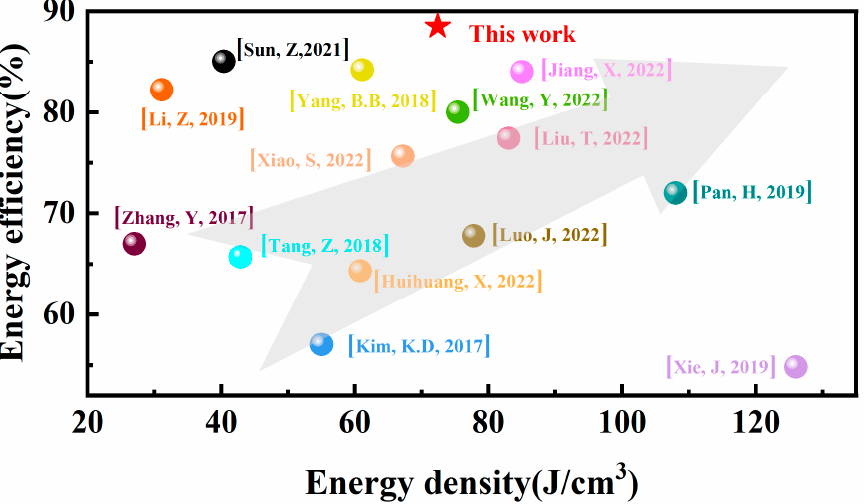
Figure 9. Energy storage density and energy storage efficiency of this work compared with other thin films.